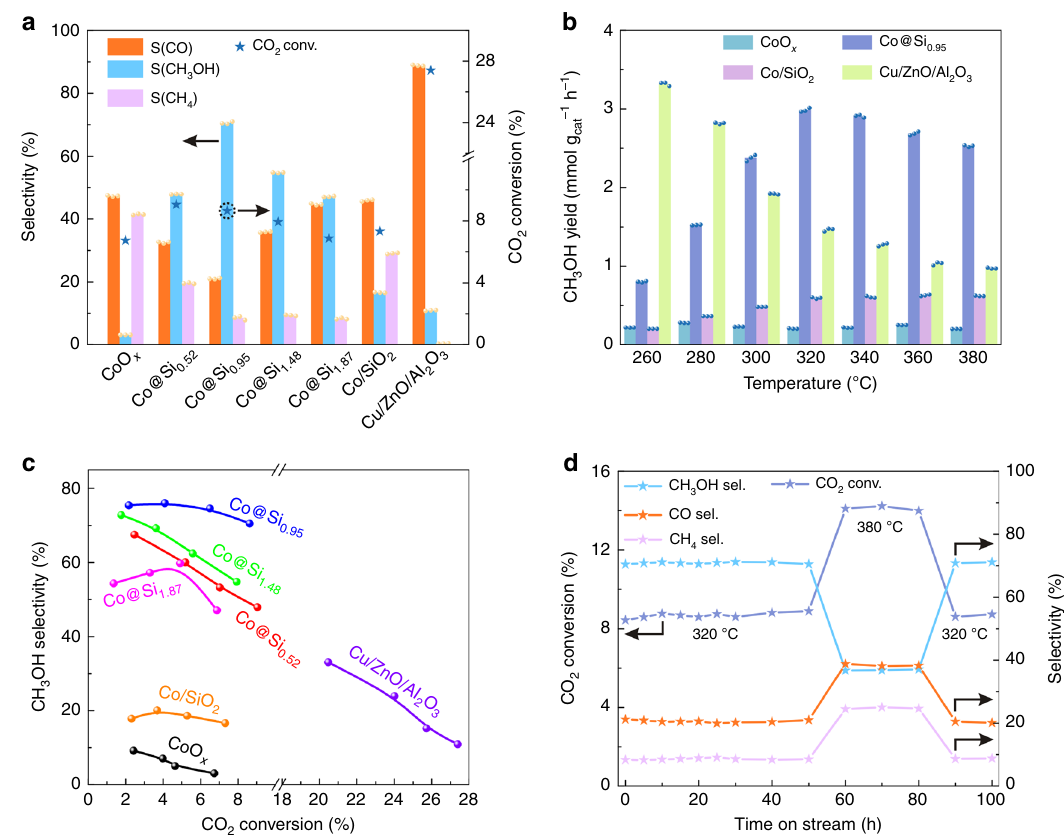
Fig. 2 Performance of Co@Si x catalysts in CO 2 hydrogenation. a Performance of catalysts, standard reaction conditions for Co@Si 0.95 : 0.2 g of catalyst, pressure = 2.0 MPa; H 2 /CO 2 feed ratio = 3:1, molar; temperature = 320 °C; GHSV = 6000 mL/g h. The mass of the other Co@Si x catalysts was chosen to give the same cobalt content in the reactor. b Dependences of methanol yield on temperature. Each reaction was performed three times, and the corresponding data points are provided in the bar charts. Error bounds for the conversion and selectivity are ± 0.3% and ± 0.5%, respectively. c CO 2 conversion and CH 3 OH selectivity of Co@Si x catalysts at 260 ‒ 320 °C. d Stability test of Co@Si 0.95 catalyst operated for 100 h in a fl ow